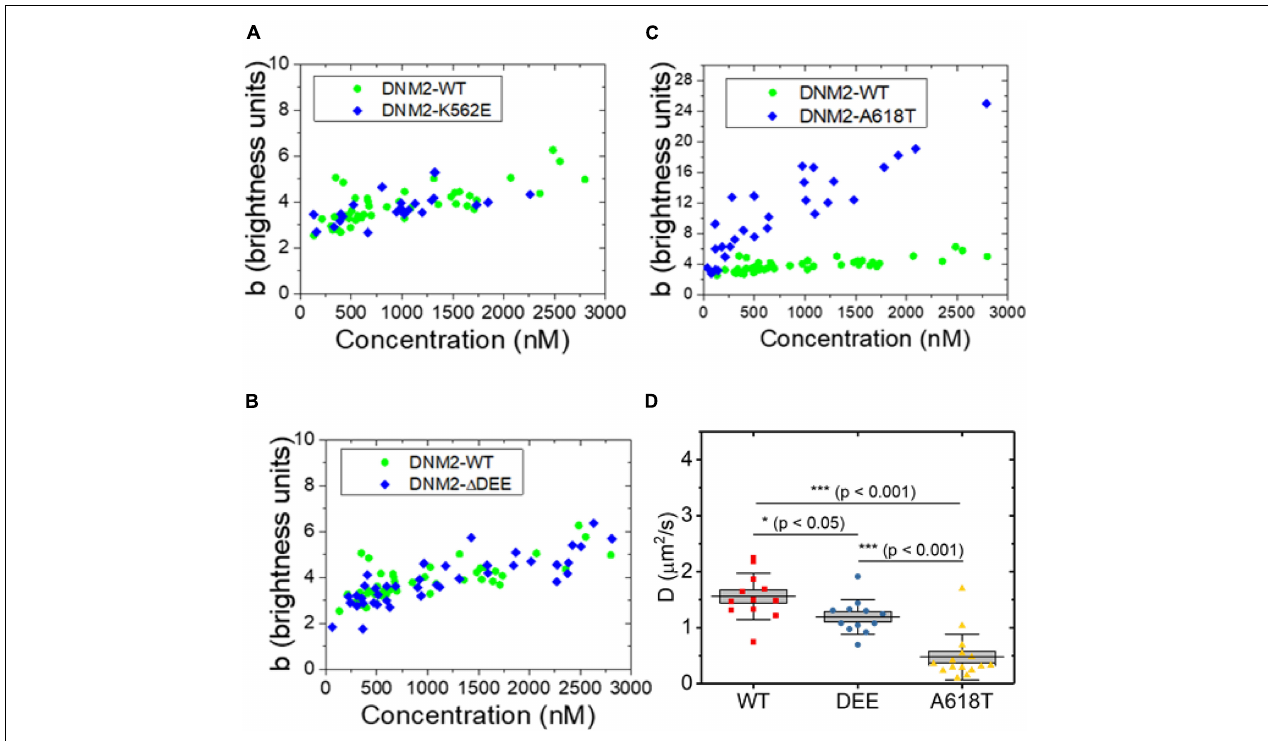
FIGURE 3 | Oligomeric states of WT and mutant DNM2 in the cytosol of U2OS cells. (A–C) DNM2 WT -EGFP (same data plotted in panels A–C ), DNM2 K562E -EGFP (panel A ), DNM2 (cid:49) DEE -EGFP (panel B ), and DNM2 A618T -EGFP (panel C ) in the cytosol of U2OS cells as a function of concentration. Monomeric EGFP in U2OS cells was used as the standard. (D) RICS analysis of DNM2 WT -EGFP, DNM2 (cid:49) DEE -EGFP, and DNM2 A618T -EGFP in NIH3T3 cells. Each data point represents the average diffusion coefficient measured in regions of 3.2 µ m × 3.2 µ m. To compare groups, p-values were calculated with the Mann-Whitney non-parametric